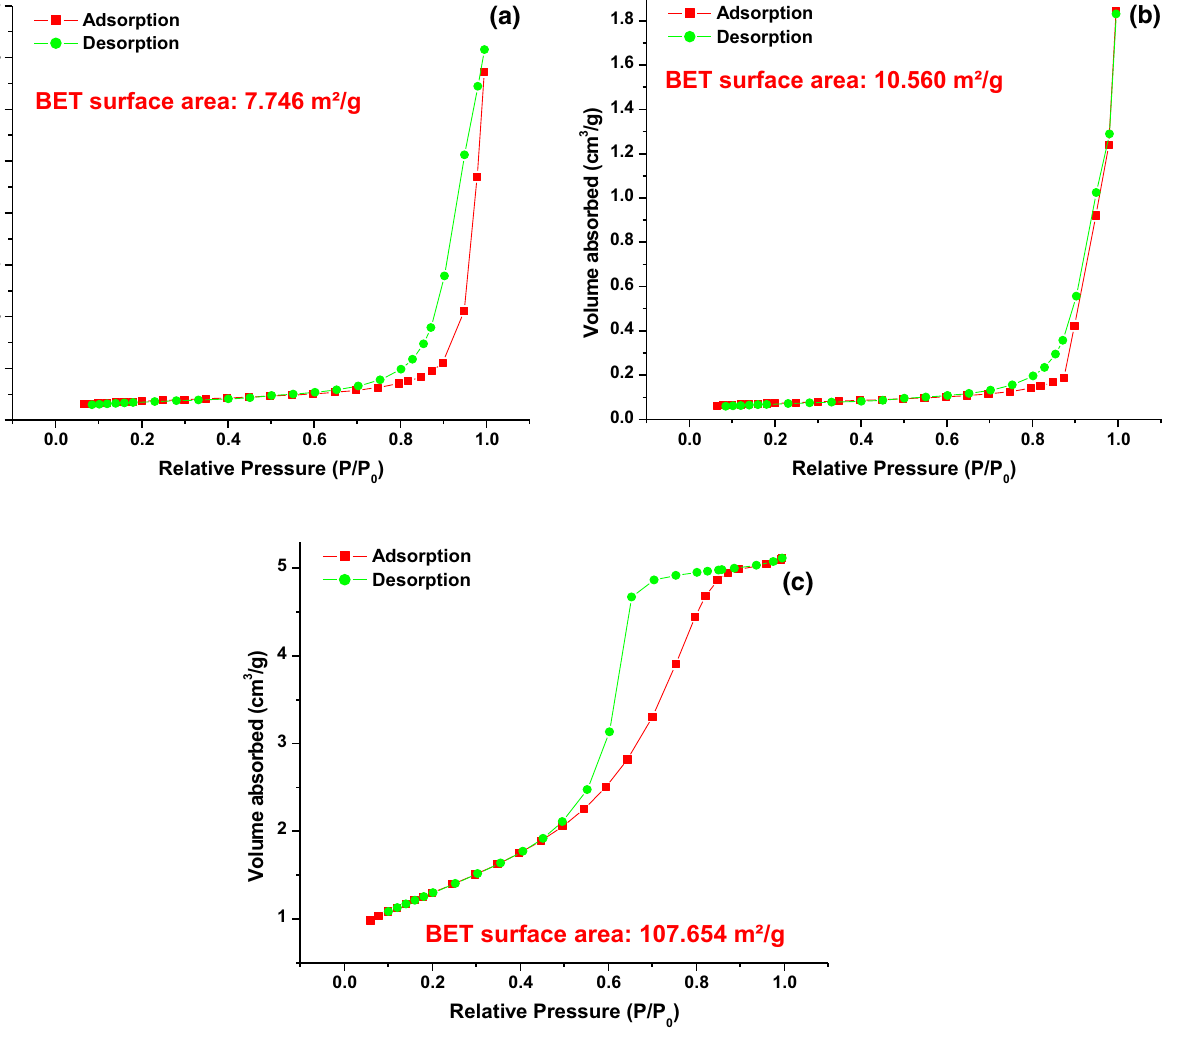
Fig. 8 BET surface area of a Ag/ZnO nanoparticles b Cd/ZnO nanoparticles; c Pb/ZnO